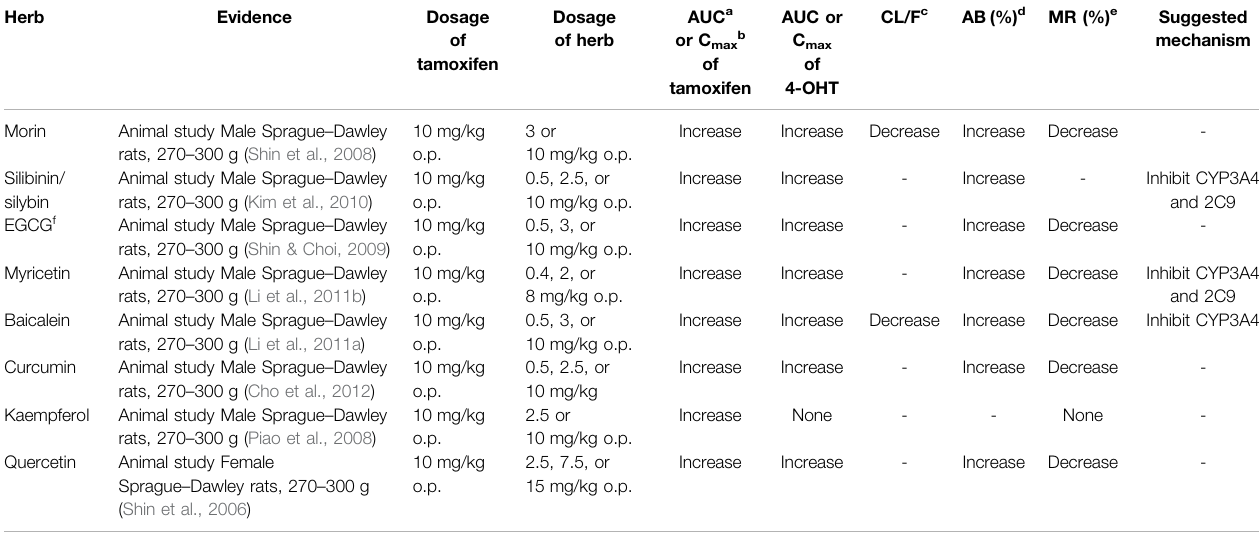
TABLE 1 | Reported pharmacokinetics interactions of natural products and tamoxifen.